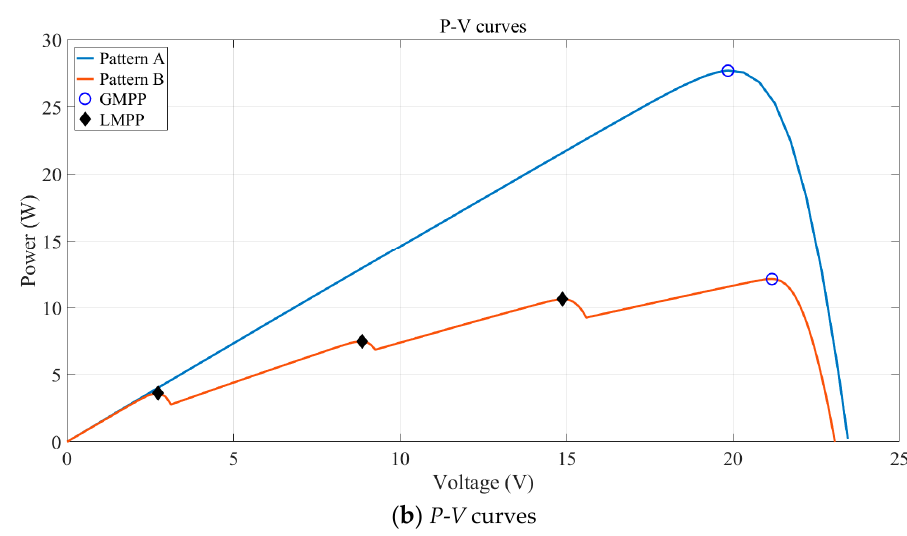
Figure 4. ( a ) I - V and ( b ) power-voltage ( P - V ) curves of the PV array under uniform irradiance and PSCs.